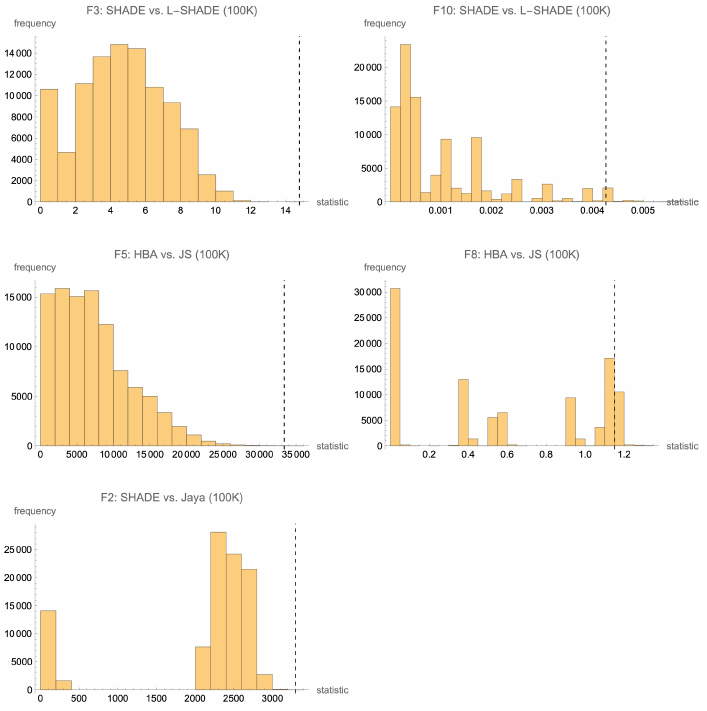
Figure 6. The distribution of statistic values from random permutations for representative functions. The dashed vertical line indicates the observed data test statistic, d